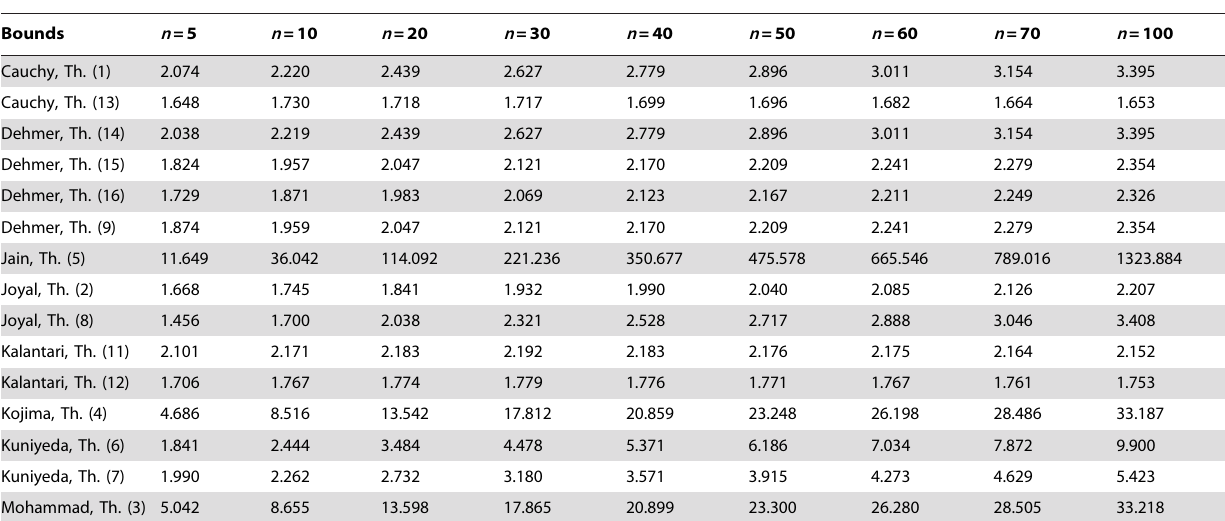
Table 4. Mean bounds values for polynomials P i [ C 4 .